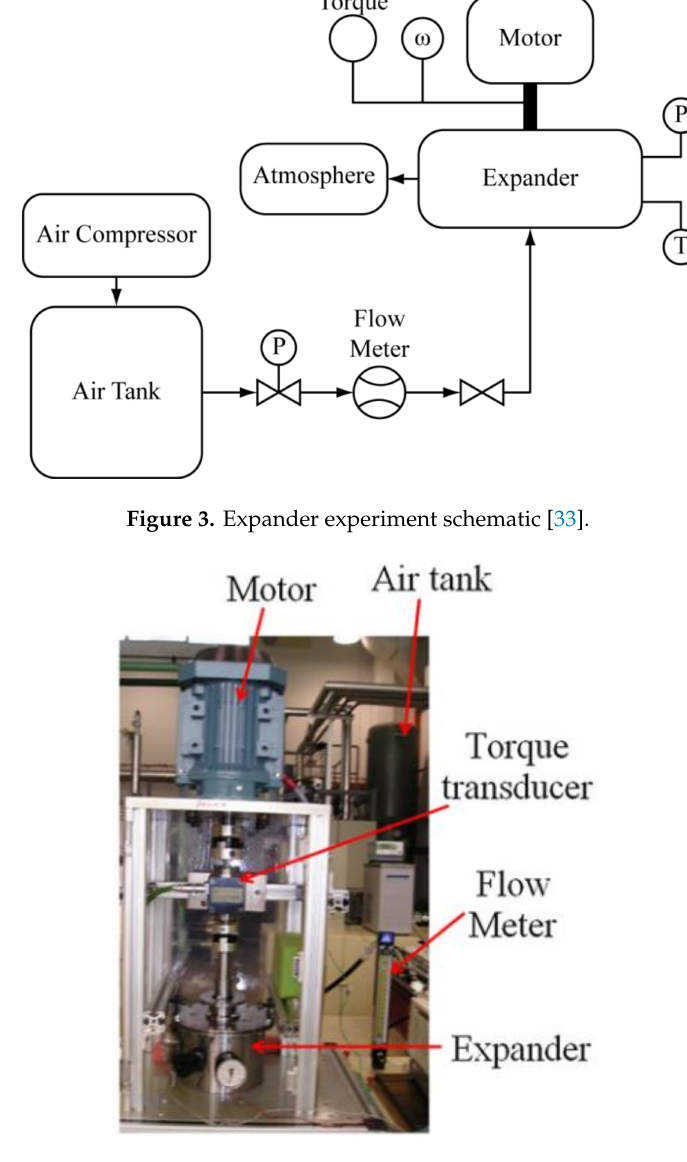
Figure 4. Expander experiment setup